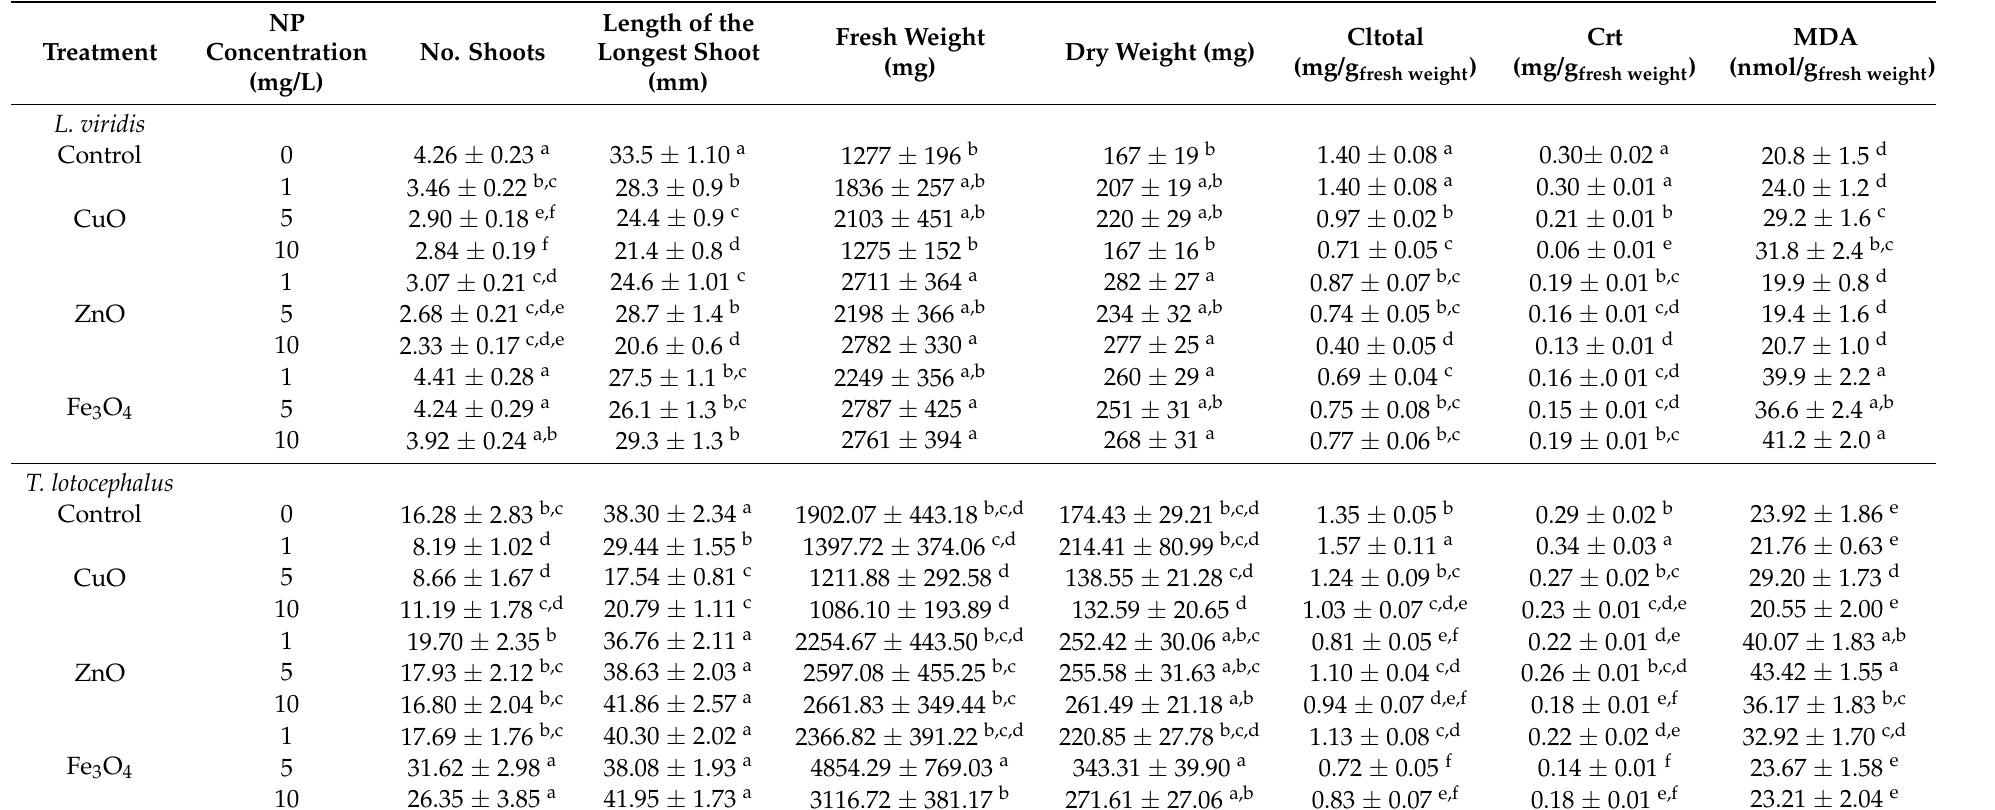
Table 1. Shoot growth and total chlorophyll (Cltotal), carotenoids (Crt) and malondialdehyde (MDA) contents in Lavandula viridis L’H é r and Thymus lotocephalus G. L ó pez and R. Morales shoots cultured in media with 0 (control), 1, 5 or 10 mg/L of CuO, ZnO and Fe 3 O 4